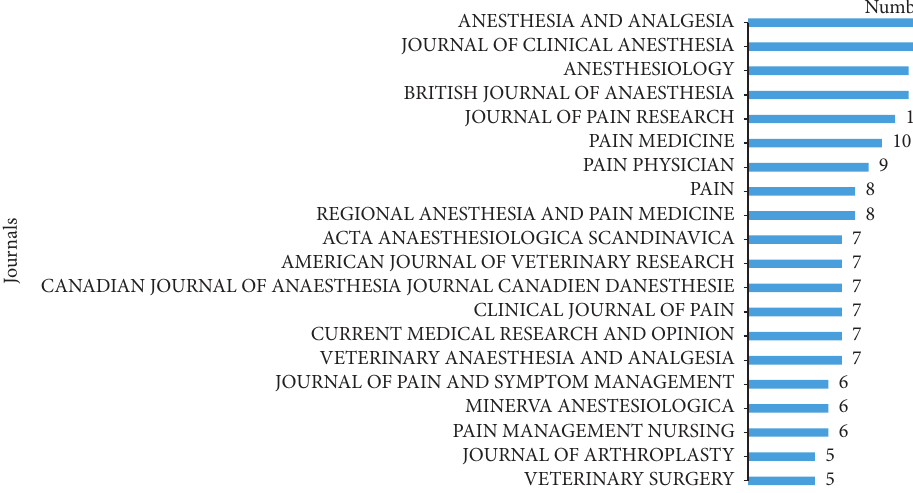
Figure 5: Top 20 journals with the most publications on analgesics in the treatment of orthopedic postoperative pain. Table 3: Co-author analysis of publications regarding analgesics in the treatment of orthopedic postoperative